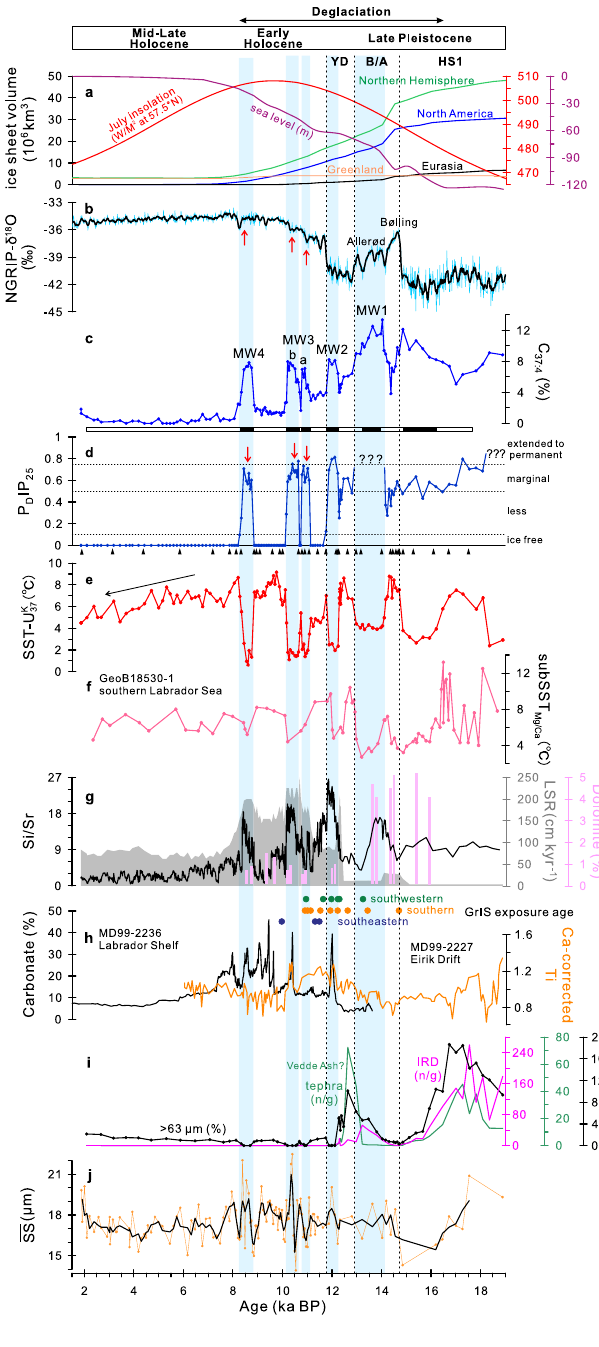
Fig. 4 Proxy records of climate trends and abrupt climate changes during the last deglaciation. a Changes in North Hemisphere ice sheet volumes 89 , global sea level 72 , and July insolation at 57.5° N 90 ; b Greenland NGRIP- δ 18 O 4 . The age of ice core was calculated from GICC05 age to cal. ka BP;